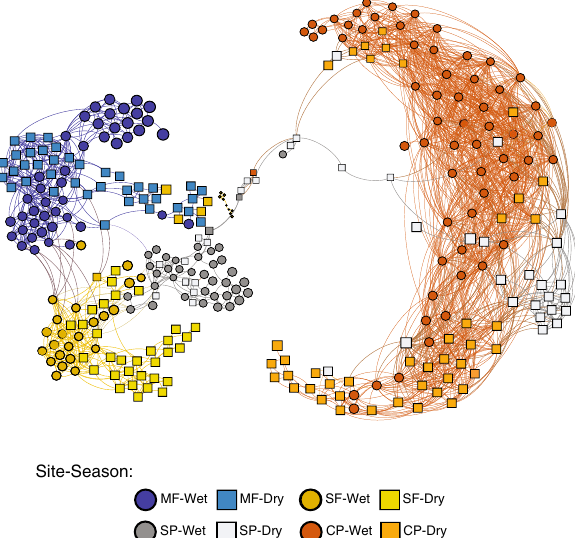
Figure 3. Inferred microbial interaction network. Network of bacterial community structure similarity between stream water samples surrounded by different land use types. The network was built based on co-occurrence of dominant ASVs in these stream bacterial communities. The network was filtered such that connections between ASVs were only kept if they were present in at least 10 samples. MF Mature Forest, SF Secondary Forest, SP Silvopasture, CP Traditional Cattle Pasture. Figure was generated using the software R version 3.6.0 (https:// cran.r- proje ct. org/), with the packages Phyloseq and igraph, and it was visualized using Gephi Graph Visualization software version 0.9.2 (https:// gephi. org/